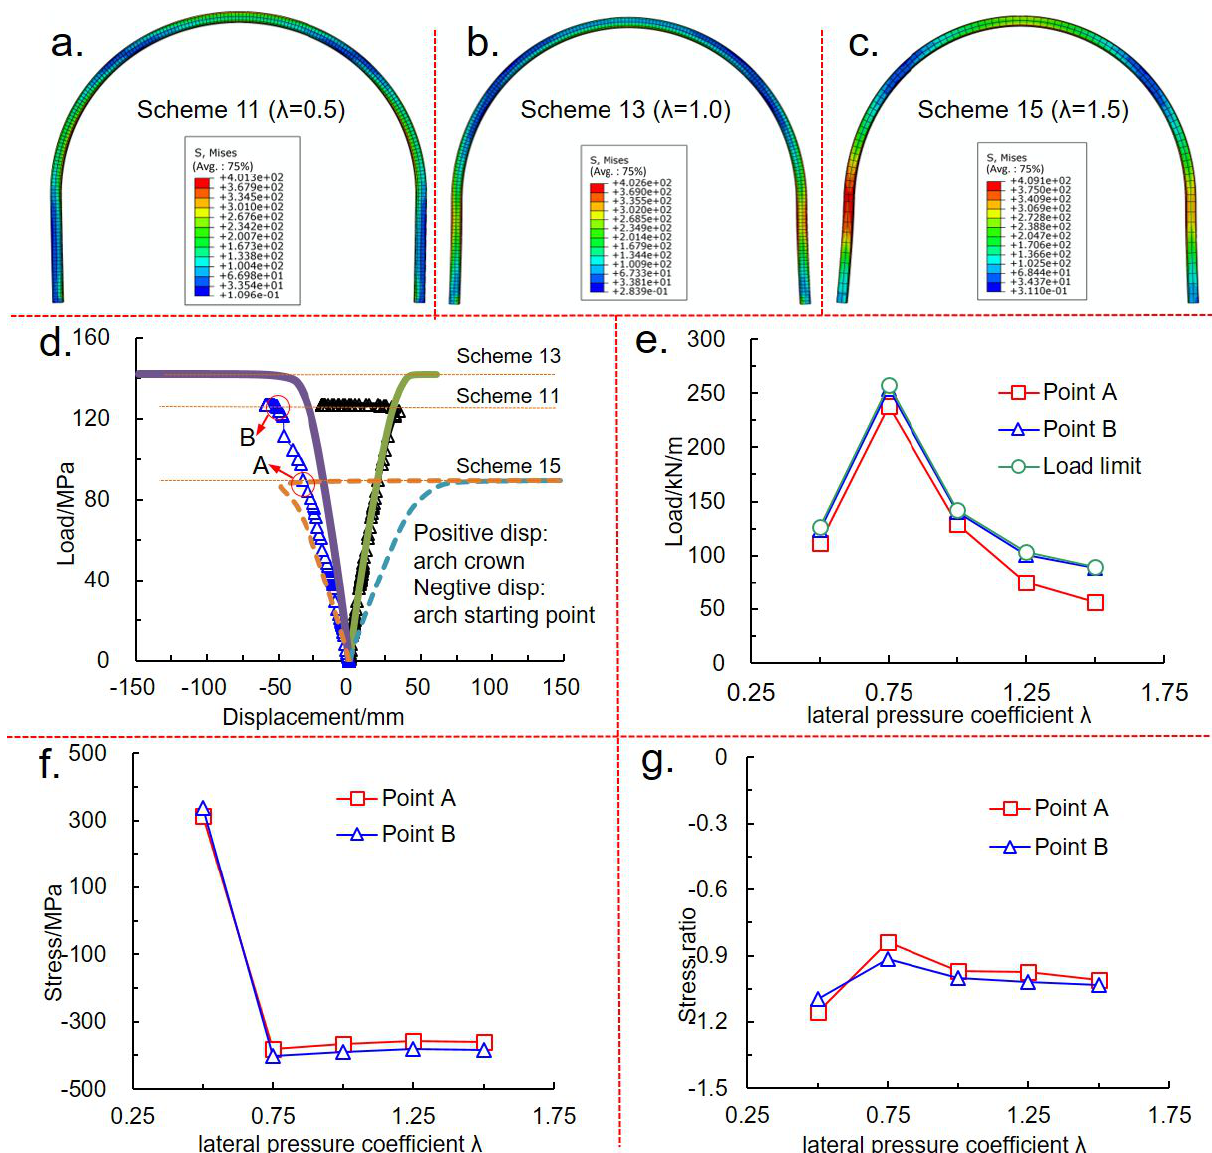
Figure 8: Typical results for Schemes 11–15 with the different lateral pressure coeflcients. (a)–(c) Stress contours and deformed shapes of the arches; (d) Load–radial displacement curves; (e) Characteristic loads influenced by the lateral pressure coeflcient; (f) Axial stress at the dangerous section, influenced by the lateral pressure coeflcient; (g) Ratio of the axial stress at the inner and outer sides of the dangerous section, influenced by the lateral pressure